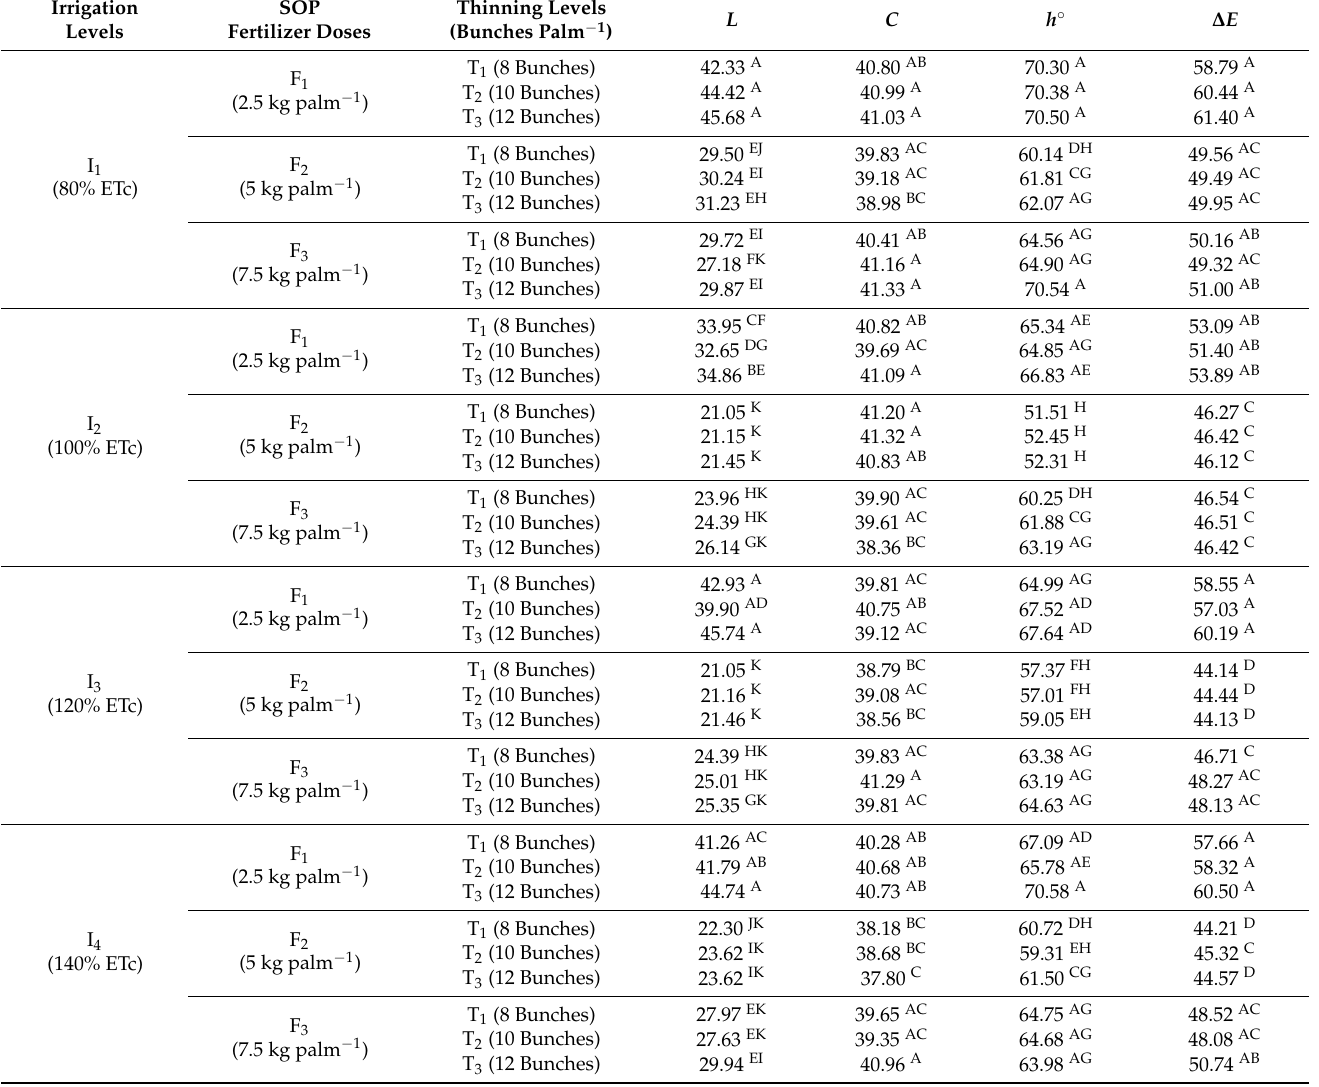
Table 5. Effects of irrigation levels, SOP fertilizer doses, and bunch thinning levels on the color parameters; lightness (L), chroma (C), hue angle (h ◦ ), and color difference ( ∆ E) of date palm cv. Sukary. Each mean data represents the averages from two seasons, 2020/2021–2021/2022. Irrigation SOP Thinning Levels L C h ◦ ∆ Levels Fertilizer Doses (Bunches Palm − 1 )